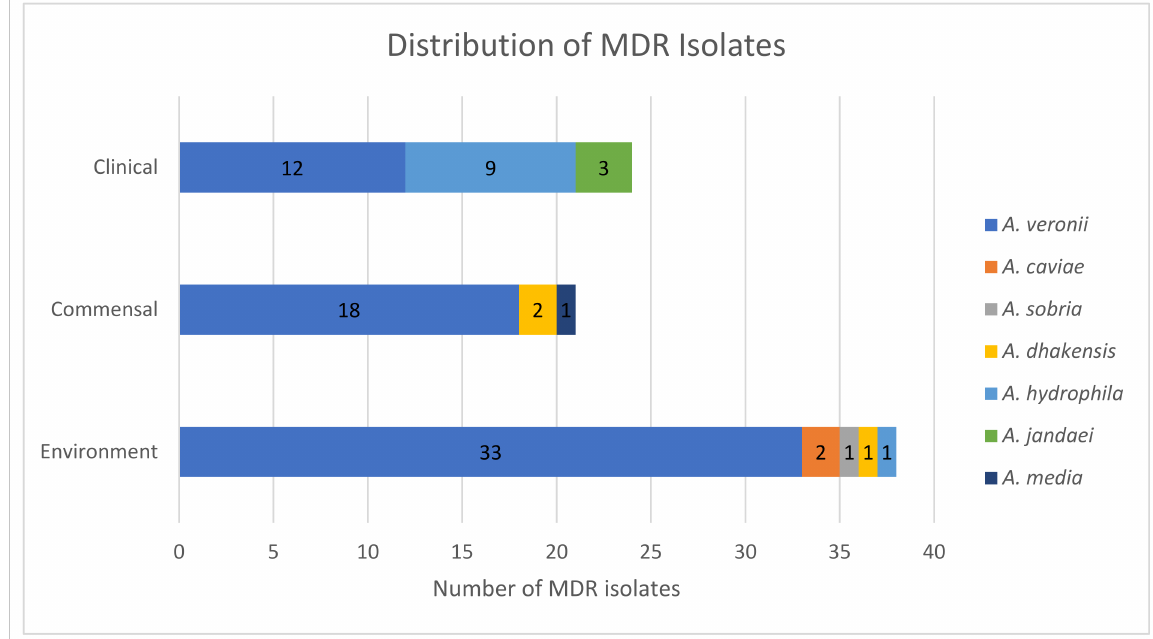
Figure 4. Distribution of MDR isolates among environmental, commensal and clinical